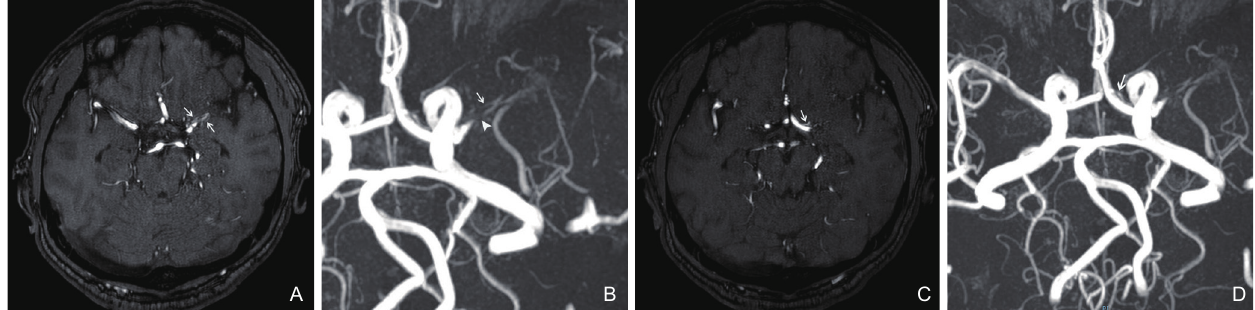
Figure 2 Representative images on MRA. (A and B) The signal of the LMCA stem was interrupted, and some light high signals were shown around it as collateral circulations. Arrows point to the collateral vessels. Arrowhead points to the site of the occluded LMCA stem. (C and D) The recurrent artery of Heubner from the LACA was shown to extend towards the region of the occluded LMCA stem. Arrows point to the recurrent artery.